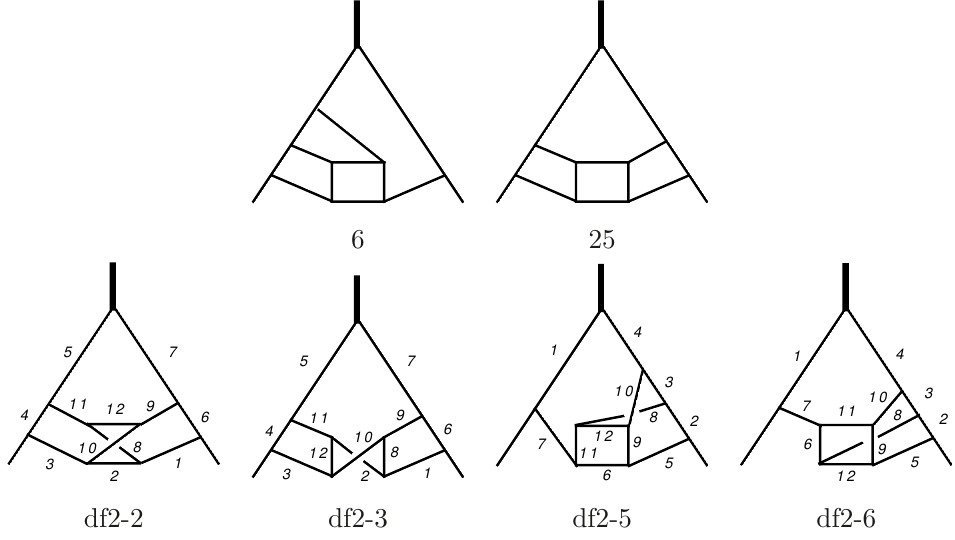
Figure 2 . Planar (top row) and non-planar (bottom row) integral families. The numbers n next to the lines correspond to the indices of the propagators, i.e. to the n th integer argument of the functions representing the integrals. In addition to the 12 propagators we have for each family six linear independent numerator factors. However, the corresponding indices are always zero for our master